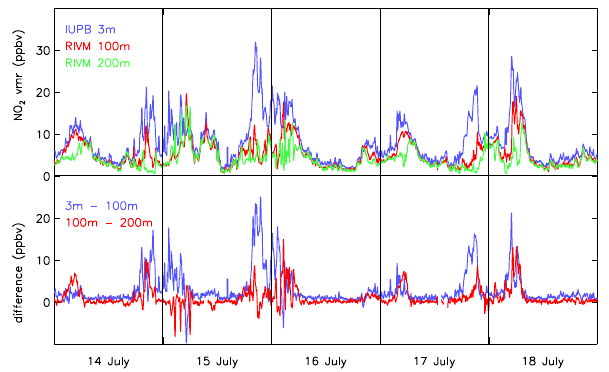
Fig. 10. In-situ measurements of NO 2 taken at different altitude levels in the Cabauw tower. All measurements are performed with NO x analysers with photolytic converters. The upper graph shows the absolute values of the measurements at each level, the lower graph the